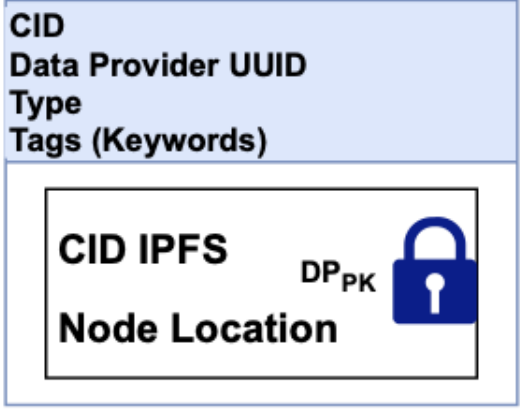
Figure 18. MAB data structure.